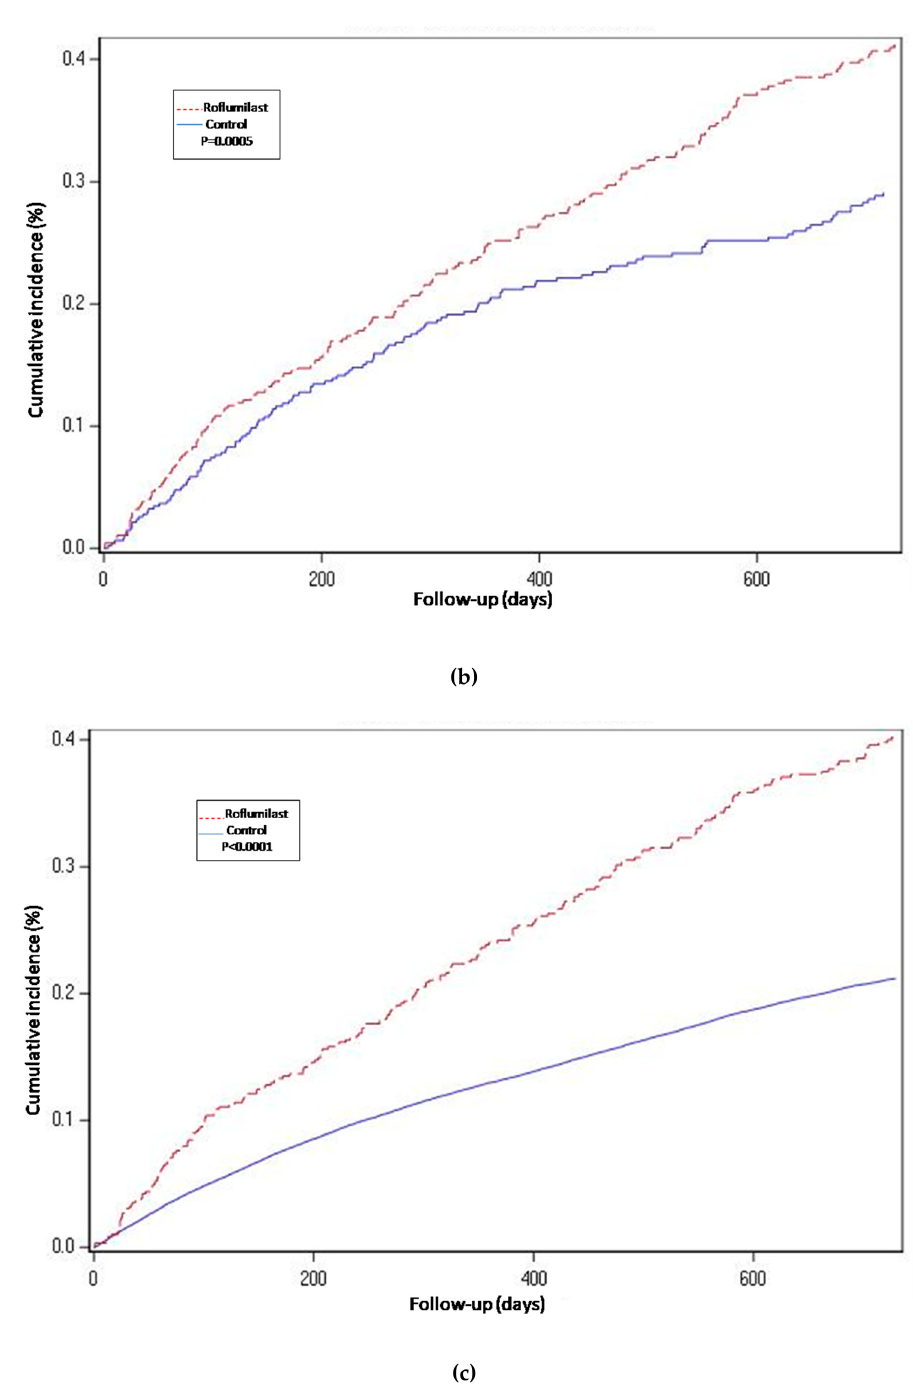
Figure 2. Years of follow-up. Hospitalization-requiring pneumonia. Cumulative incidence curves for the three compared groups. ( a ) Propensity-matched population (Roflumilast vs. Control): Unadjusted Cox proportional hazard model (matched on FEV1, MRC, age, gender, smoke status, number of AECOPD-Hosp 1 year prior to baseline, ICS prescription and LAMA / LABA prescription). ( b ) Roflumilast versus Theophylline: unadjusted Cox proportional hazard mode (Propensity score matched on FEV1, MRC, age, gender, smoke status, number of AECOPD-Hosp 1 year prior to baseline, ICS prescription, LAMA / LABA prescription and calendar year). ( c ) Unmatched population (Roflumilast vs. Control): adjusted Cox proportional hazard model (adjusted for FEV1, MRC, age, gender, smoke status, number of AECOPD-Hosp 1 year prior to baseline, ICS prescription and LAMA / LABA prescription). Follow-up period of two years.